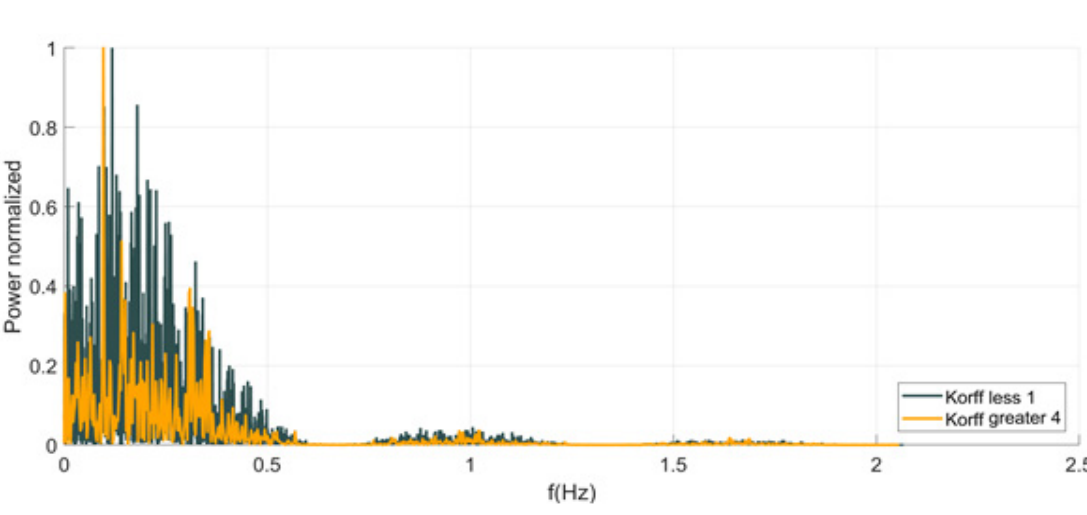
Figure 5. Display of the spectra of the reference group (black) and the pain group.